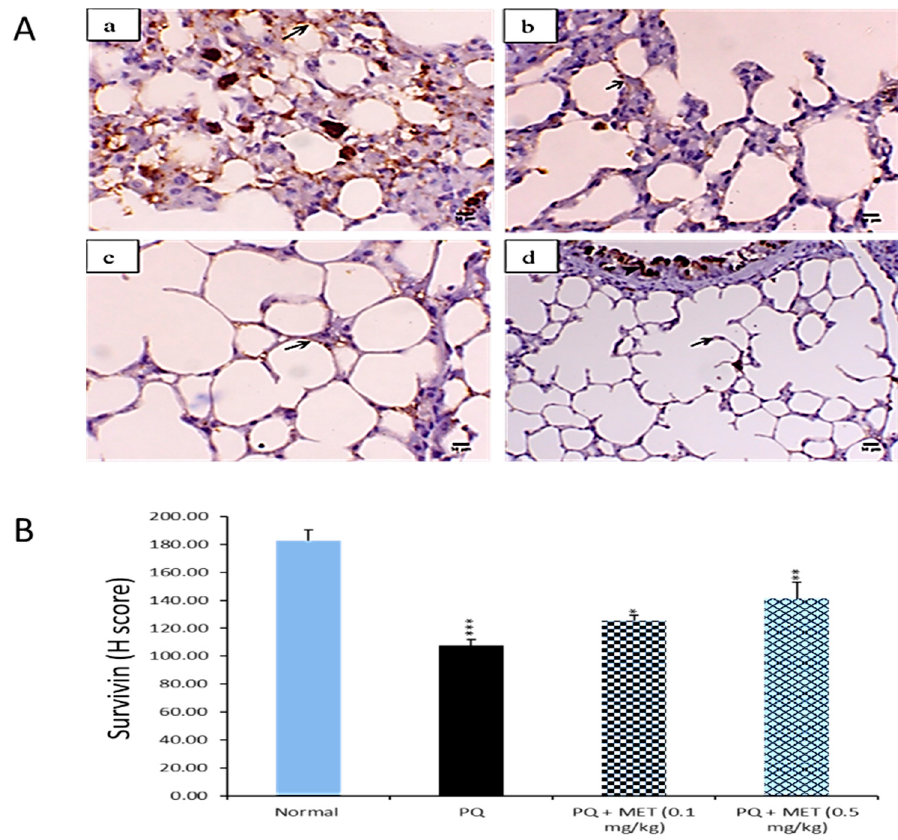
Figure 8. Effect of treatment with melittin (MEL) on the survivin protein level in lung tissues. A : Representative lung immunohistochemical graphs (a: control group, b: paraquat (PQ) group, c: PQ + MEL (0.1 mg/kg) group, d: PQ + MEL (0.5 mg/kg) group); ( a ) showed a strong survivin expression within the alveolar epithelium (arrow) (X400, scale bar = 50 µm). ( b ) presented a low to mild survivin expression within the alveolar epithelium (arrow) (X400, scale bar = 50 µm). ( c ) indicated a moderate survivin expression in the alveolar epithelium (arrow) as well as in the bronchial epithelium (arrowhead) (X400, scale bar = 50 µm). ( d ) illustrated an increase in the survivin expression in the alveolar epithelium (arrow) and in the bronchial epithelium (arrowhead) (X200, scale bar = 100 µm). B : Statistical analysis of survivin H-score. Data are expressed as mean ±SD. Significantly (* p < 0.05, ** p < 0.01, *** p < 0.001) different from PQ group.